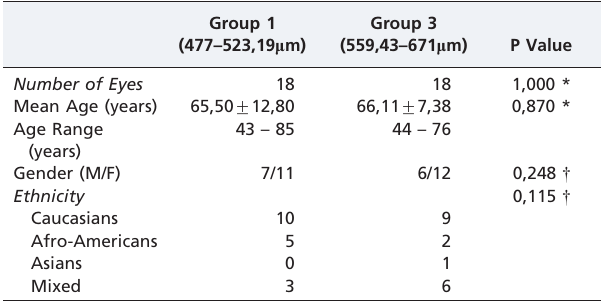
Table 1 - Demographic data according to Central Corneal